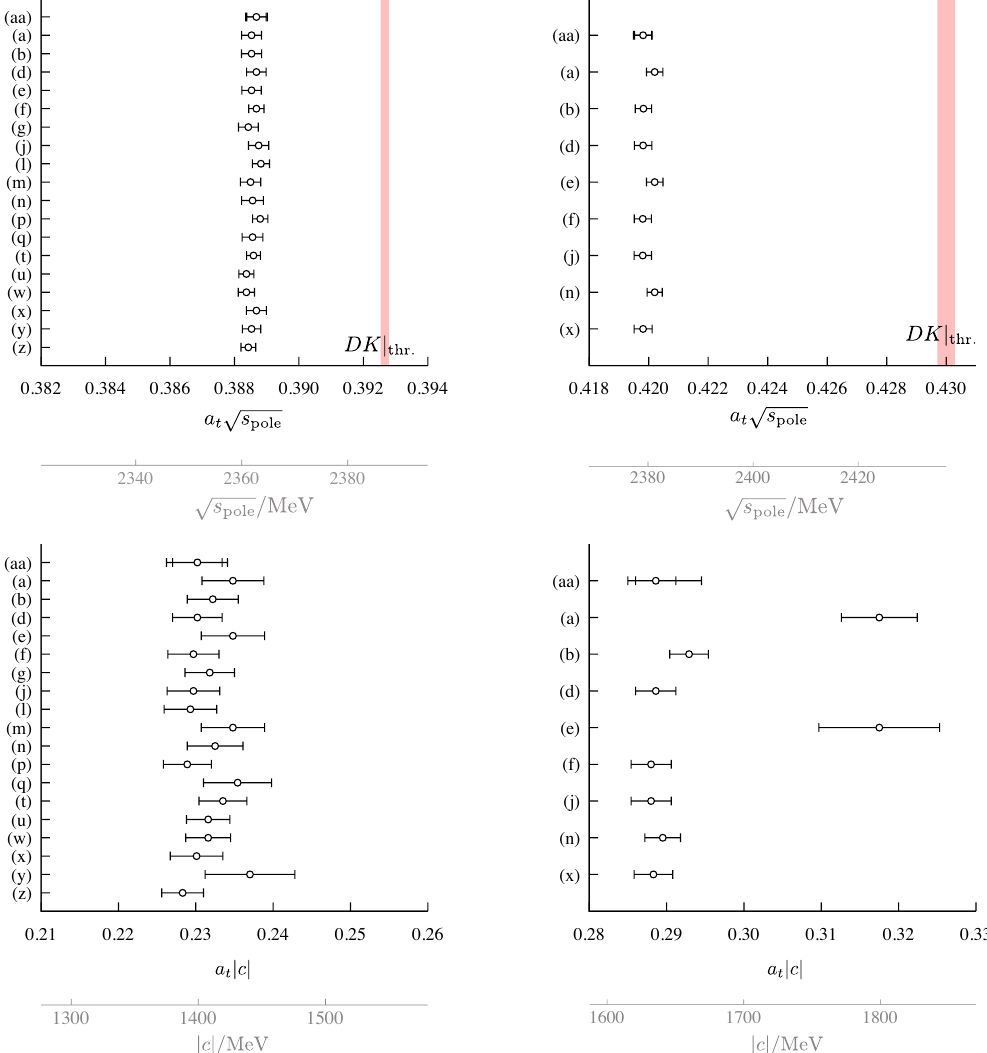
Figure 17 . Upper : the location of the pole singularity on the real axis of the physical sheet in the I = 0 DK S -wave scattering amplitudes, for all the acceptable parametrisations in table 4, on the m π = 239 MeV (left) and m π = 391 MeV (right) ensembles. The error bars give the statistical uncertainty, and the outer error bars on the reference amplitudes include also the uncertainty from varying the D and K meson masses and the anisotropy as described in the text. The red band shows the location of DK threshold. Lower : the corresponding coupling, | c |